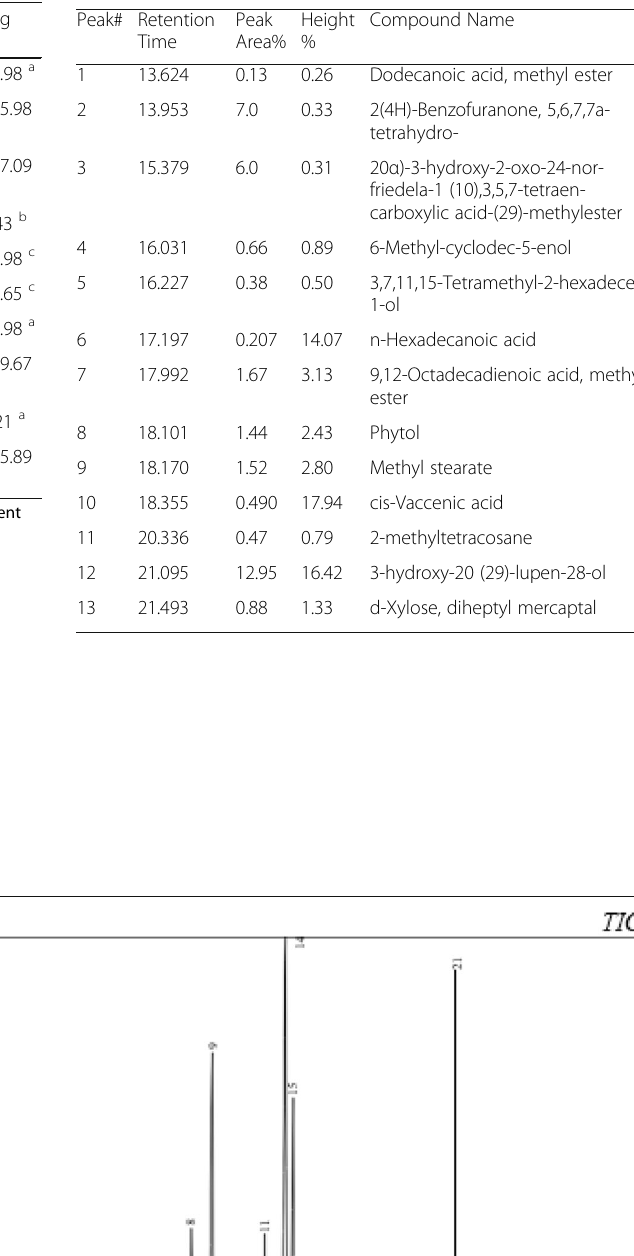
Table 5 Effect of purified fraction of M. senegalensis leaf on biochemical parameters in mice